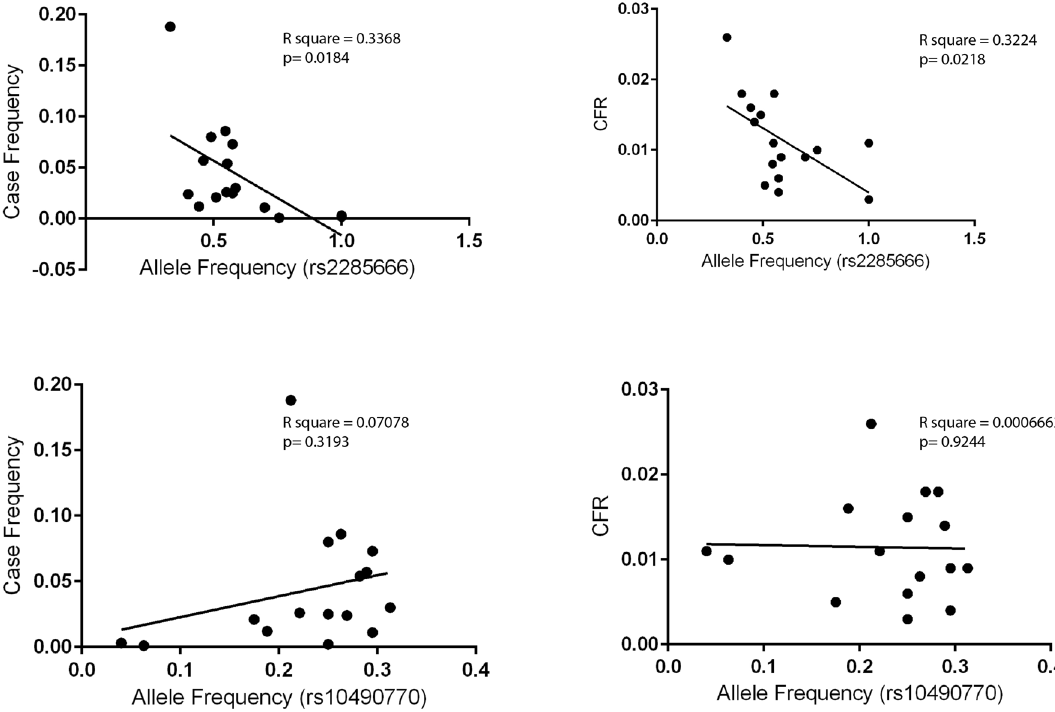
Figure 1. The regression analyses of rs2285666 ( ACE2 ) and rs10490770 ( LZTFL1 ) with the COVID-19 cases as well as case fatality rate in various states of India (Supplementary Table